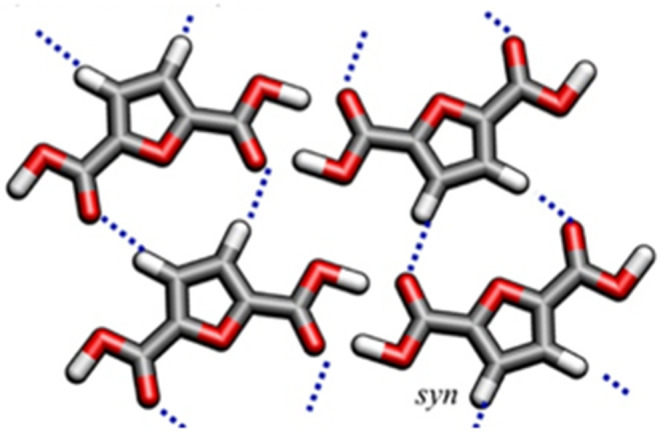
Molecular model for the syn conformer of 2,5-FDCA at the B3LYP/6-311++G(d,p) level. Reproduced with permission from Araujo et al. (2018). Copyright (2018) American Chemical Society.